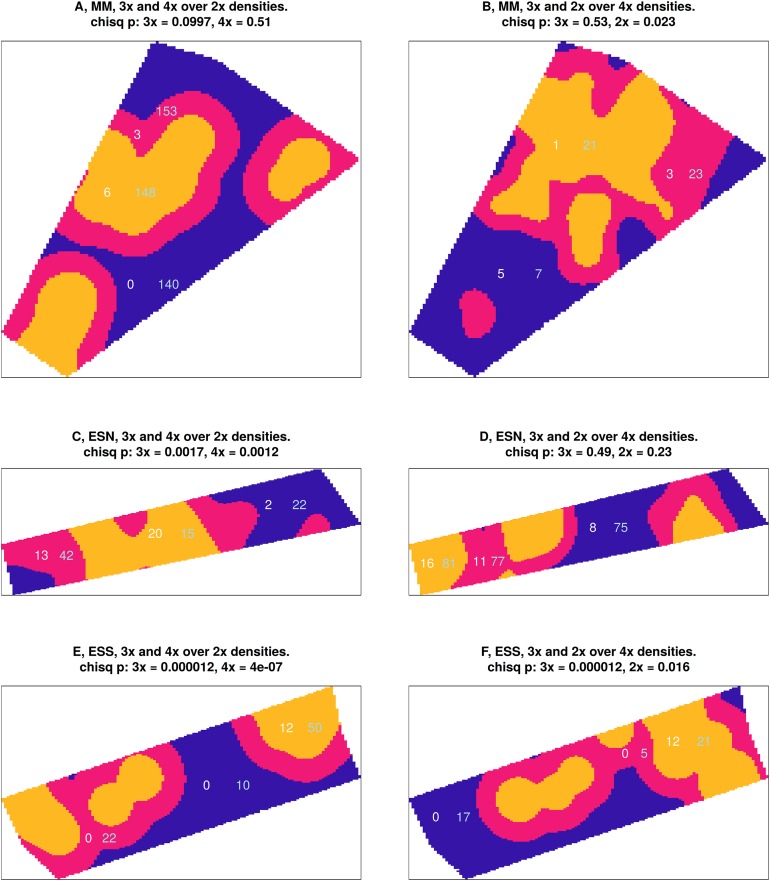
Relationship between the abundance of C. x subdecurrens (3x) and both parentals (numbers in white) and C. aspera (2x) and C. seridis (4x) (numbers in light blue) at three sampling plots.(A and B) Marjal dels Moros (MM); (C and D) El Saler North (ESN), and (E and F) El Saler South (ESS). (A, C, E) The number of C. x subdecurrens and C. seridis individuals over different densities of C. aspera, and (B, D, F) the number of C. x subdecurrens and C. aspera individuals over different densities of C. seridis. Significant Chi-square differences between number of individuals of one taxon over the three equal-area density parts (yellow: high, pink: medium, and blue: low density of the other taxon) are marked.